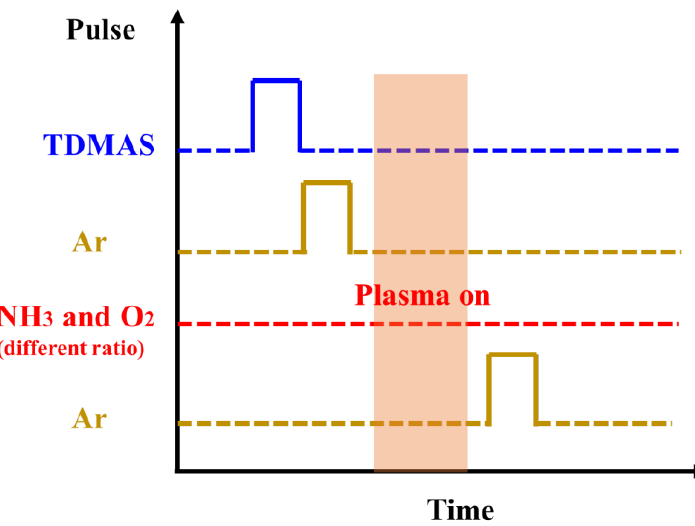
Figure 1. Parameters of one atomic layer deposition (ALD) cycle of the SiON growth utilized in this work.